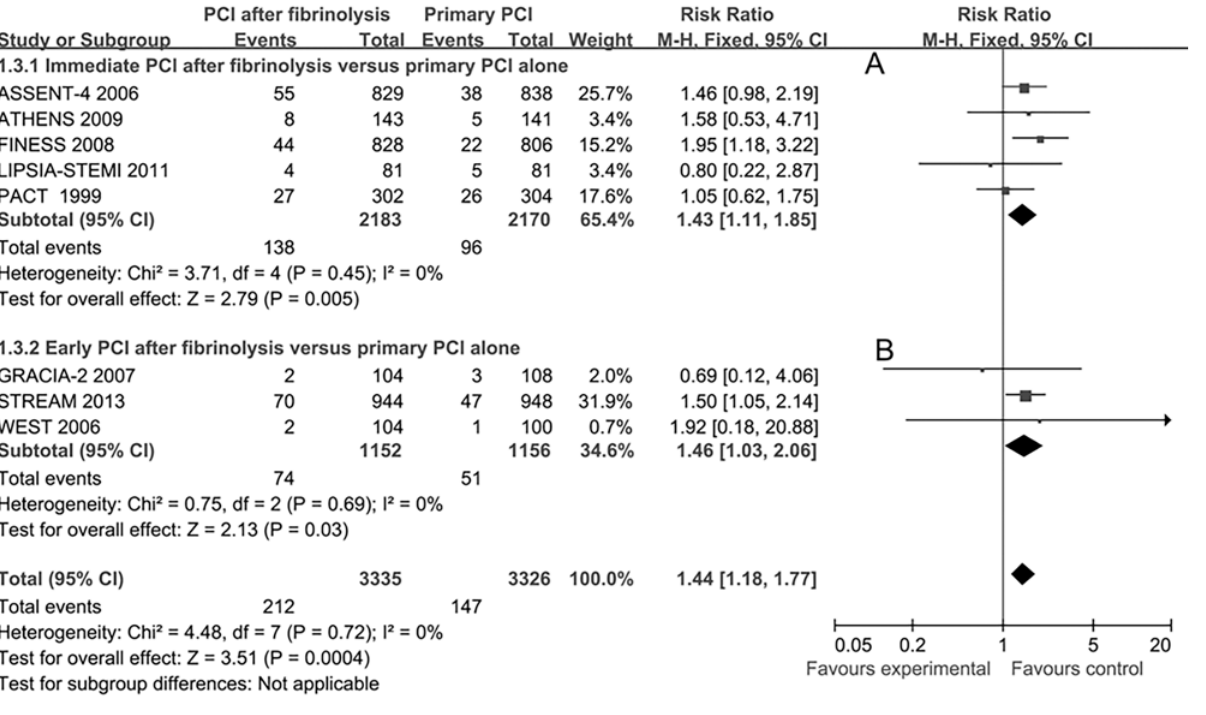
PLOS ONE | DOI:10.1371/journal.pone.0141855 November 2,